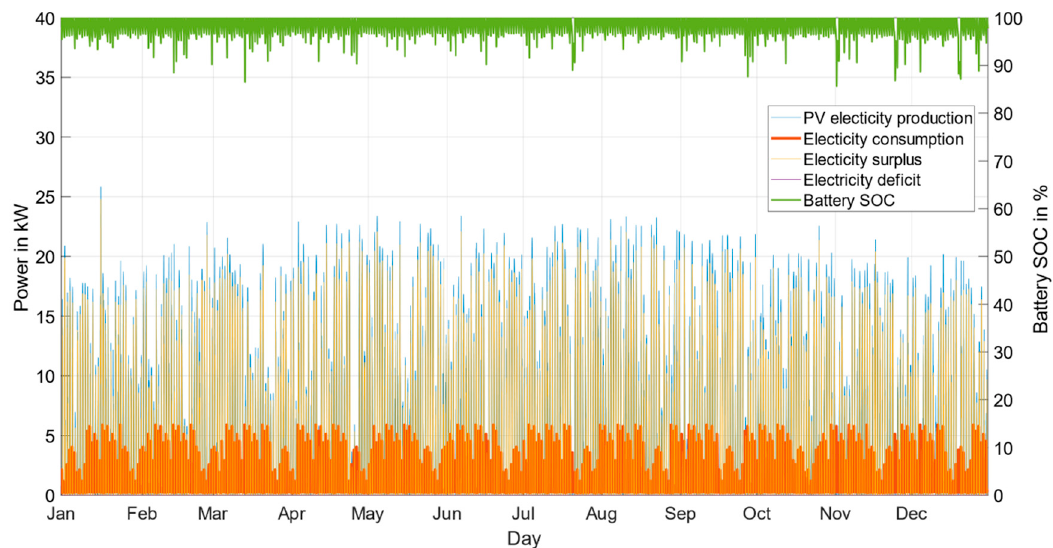
Figure 15 . Annual hourly PV electricity production, demand, surplus in kW. Figure 15. Annual hourly PV electricity production, demand, surplus in